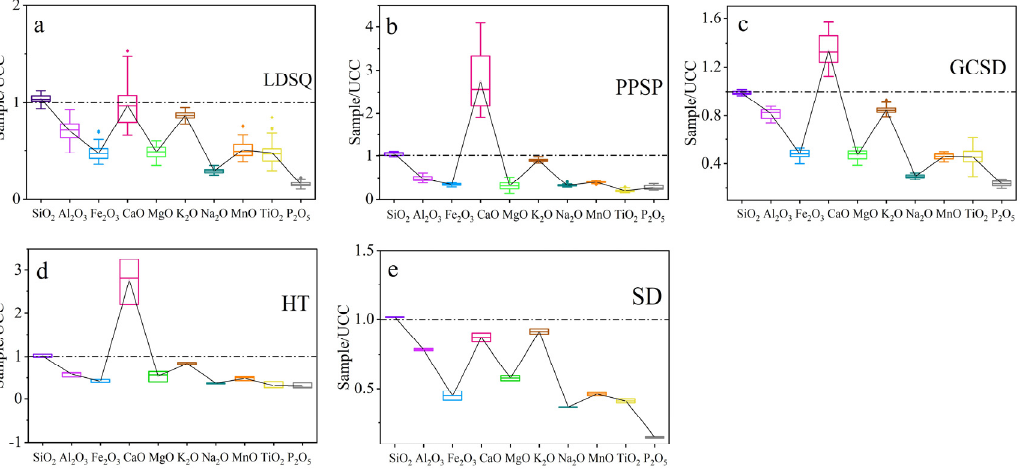
Figure 3. UCC-standardized box line diagram of trace elements for different types of sediments: ( a ) represents mobile dune, ( b ) represents climbing sand sheet, ( c ) represents nebkha, ( d ) represents flood plain, and ( e ) represents lakeshore. UCC datas are reprinted with permission from ref. [38]. 1985, Taylor and McLennan. Table 2. Average content of trace elements in modern dunes